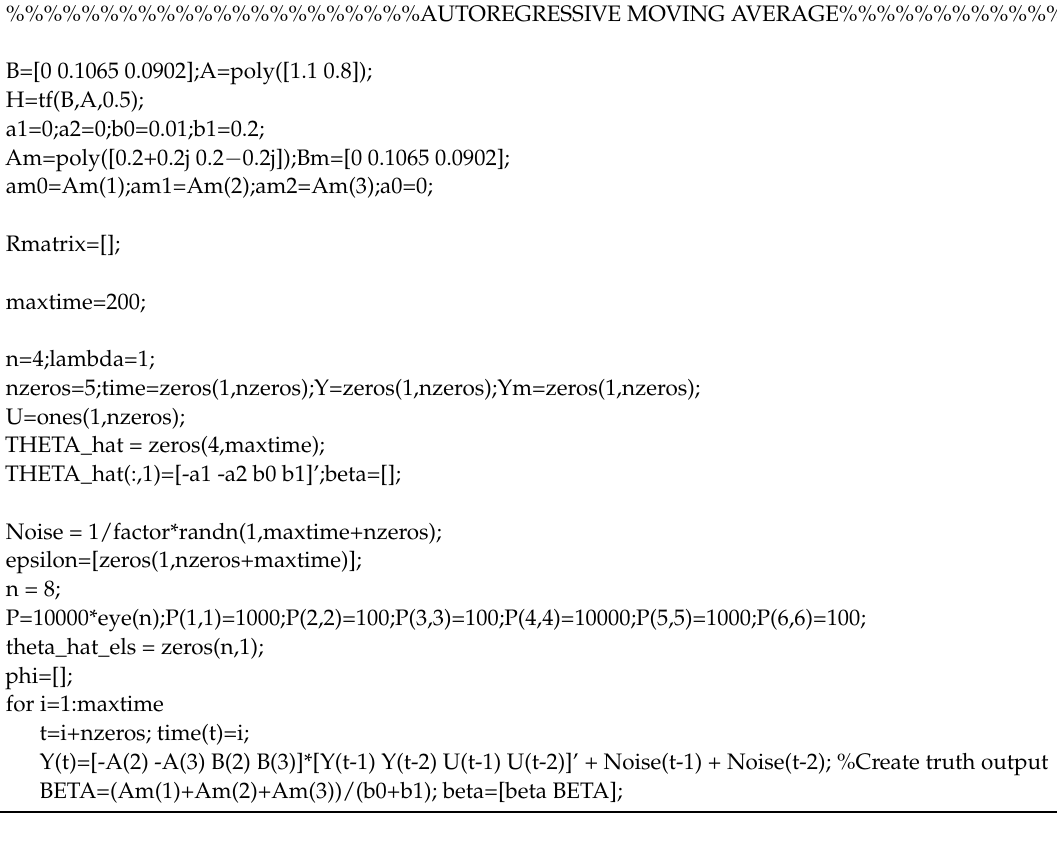
Algorithm A2 Autoregressive moving